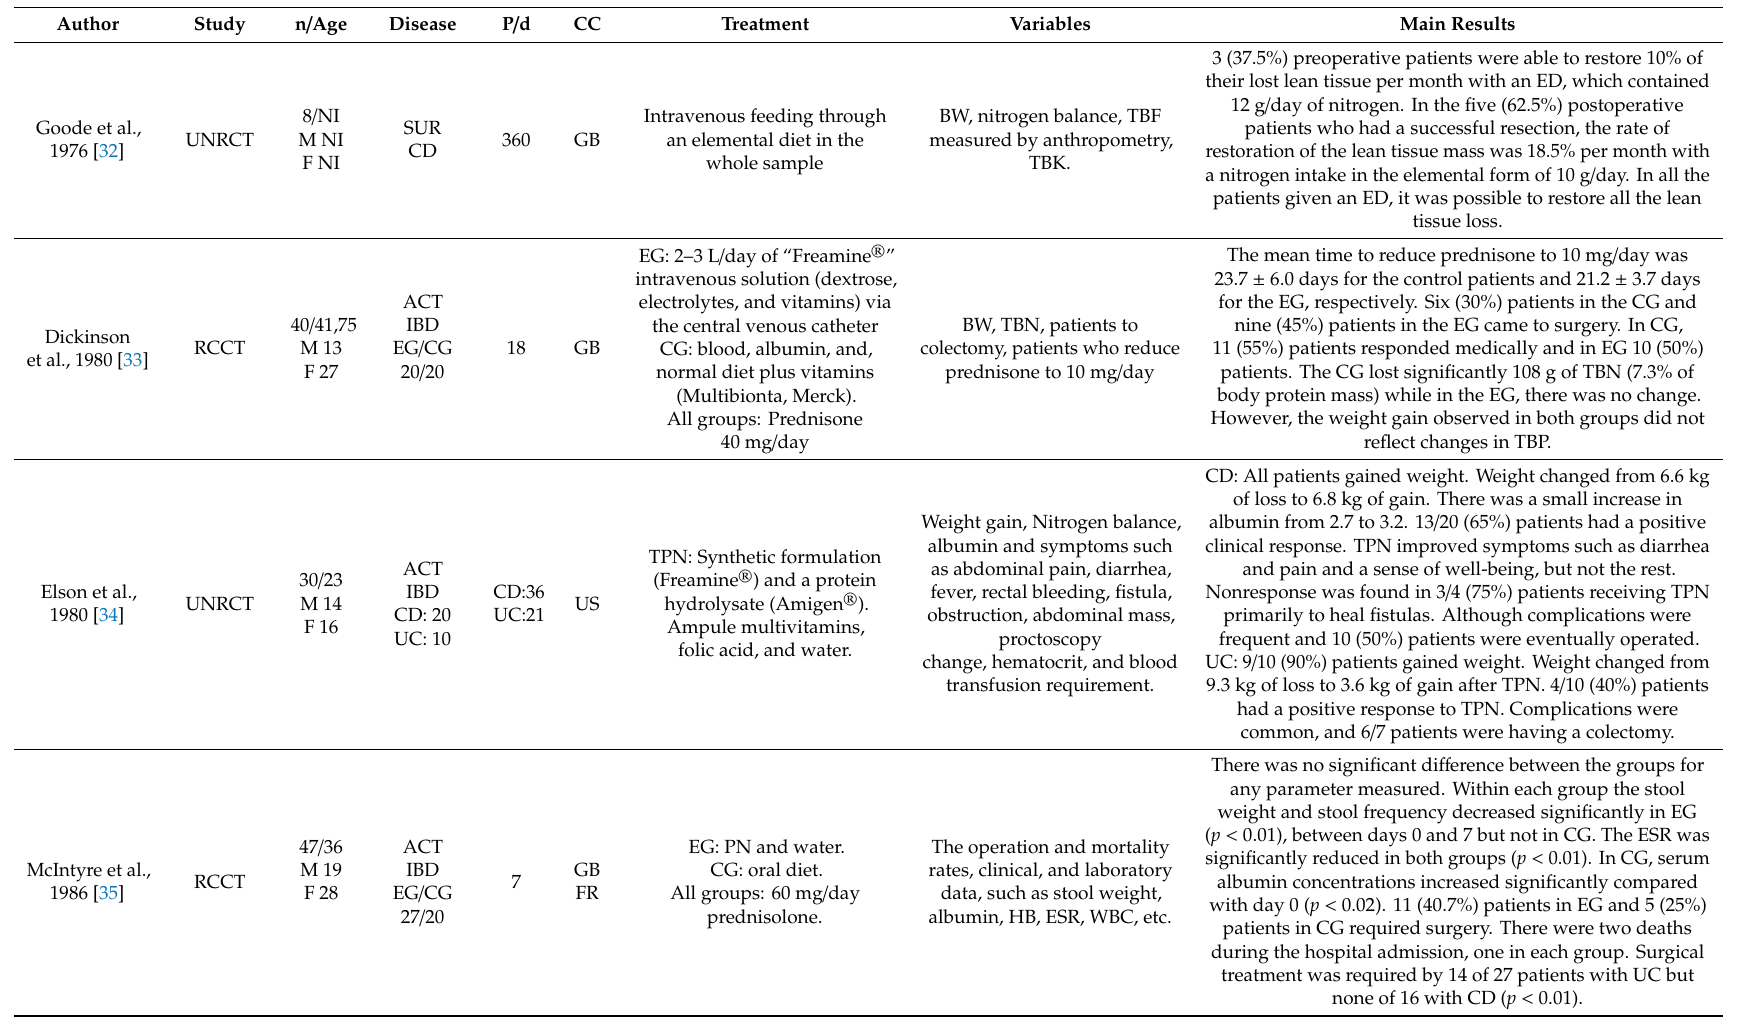
Table 1. Main results of the systematic